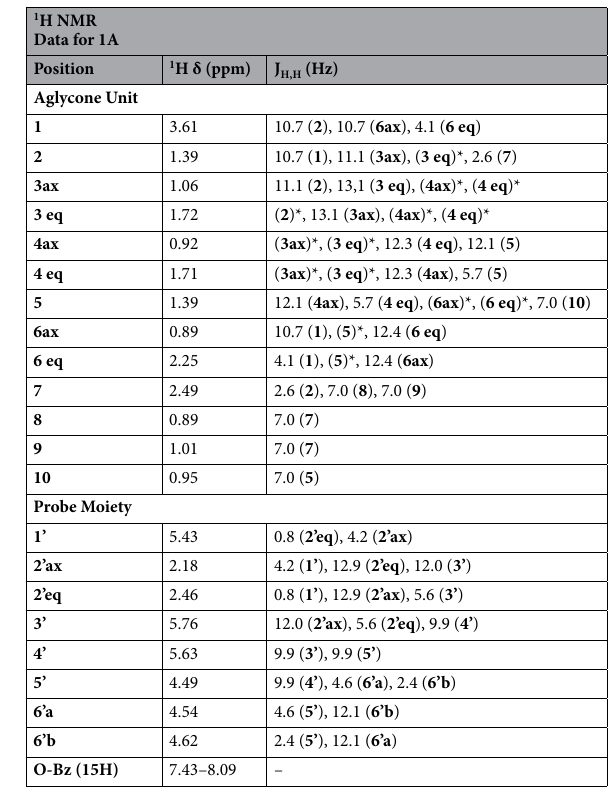
Table 2. Chemical proton shifts and coupling constants for molecule 1A second. *These coupling constants could not be measured. Signal pattern remains partially unclear due to serve signal overlap and higher order effects.